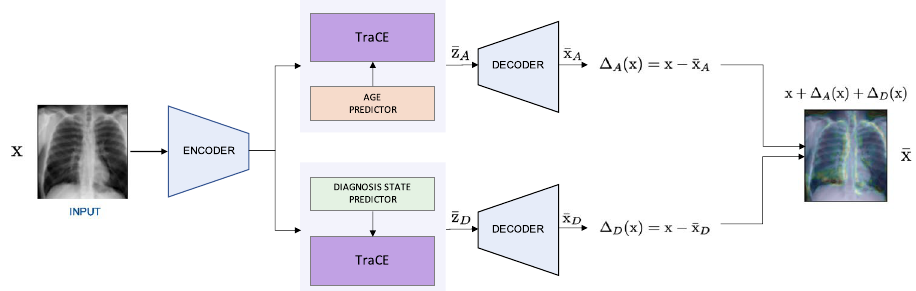
Figure 4. Using TraCE to infer relationships between a patient attribute (e.g., age) and disease states. For this analysis, we construct two independent predictive models, i.e., age and diagnosis state, and synthesize counterfactuals based on hypothesis on each of the predictions (e.g., patient age should be predicted as 70 while the diagnosis state should be abnormal . Finally, we combine the changes induced in the two counterfactuals, � A ( x ) and � D ( x ) respectively, and check if incorporating age-specific patterns strengthens the evidence for the abnormal class.